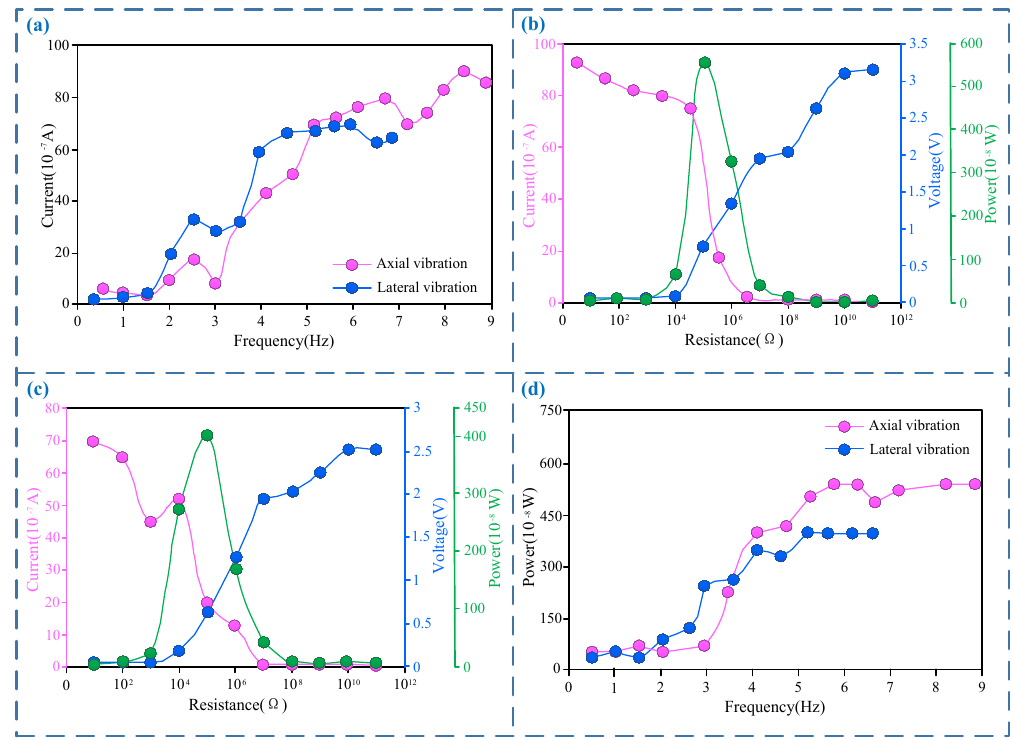
Figure 5. Results of power generation function tests. ( a ) Output current of the axial and the lateral vibration at different frequencies; ( b ) output current, voltage, and power of the axial vibration under different loads; ( c ) output current, voltage, and power of the lateral vibration under different loads; and ( d ) output power of the axial and the lateral vibration at different frequencies.